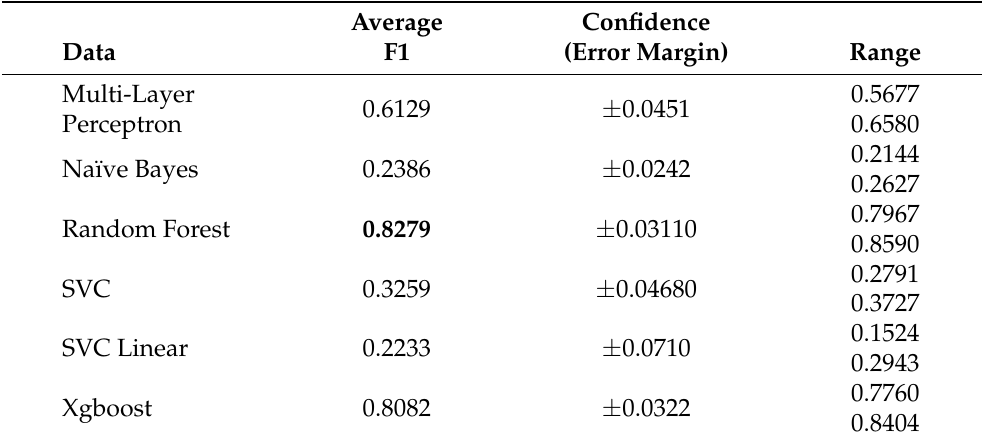
Table 5. Mean F1 by model type, confidence interval calculated to 95% with population sizes 180, 180, 180, 163, 99, and 180, respectively. Bold font indicates highest average F1 score.